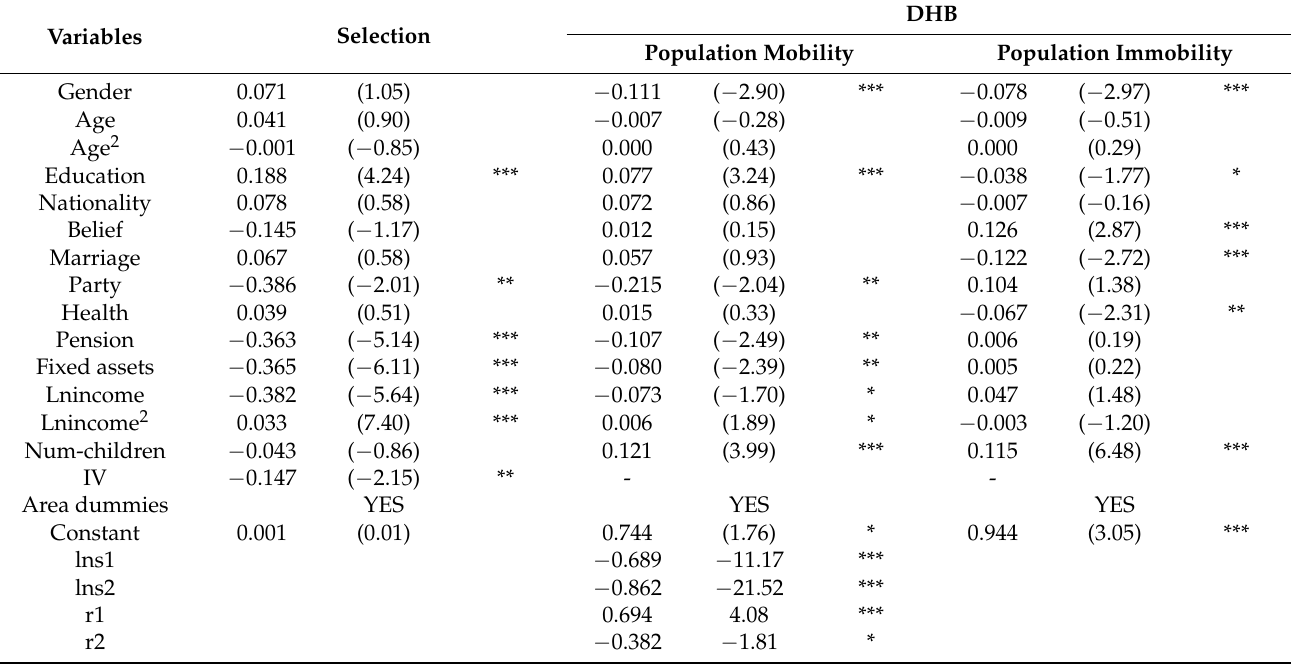
Table 7. The estimates for the determinants of RPM and